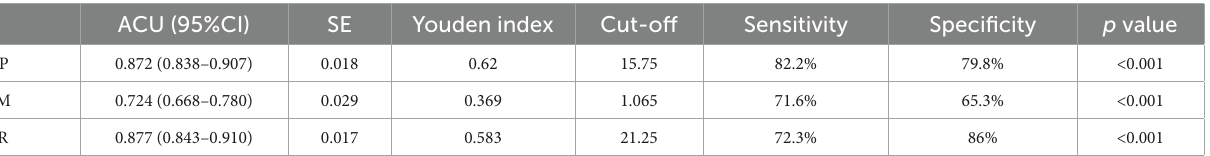
TABLE 2 Characteristics of ROC curves in COVID-19